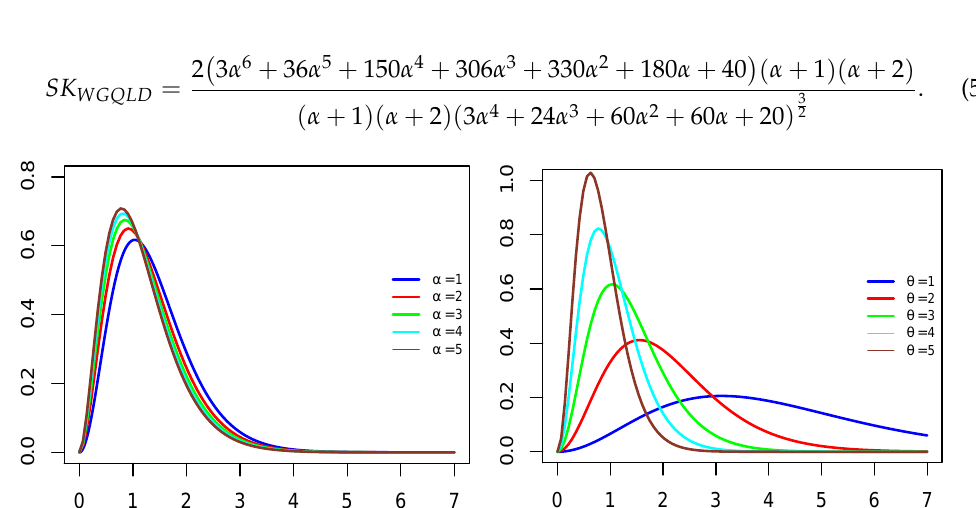
Figure 1. Plots of the WGQLD PDF with θ = 3 ( left ) and α = 1 ( right ) for some parameters’